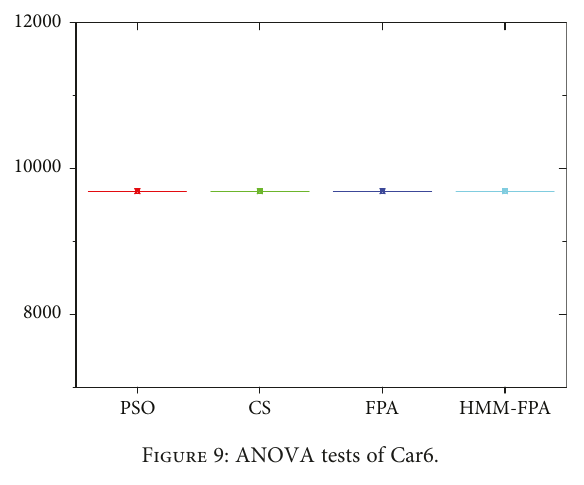
Figure 9: ANOVA tests of Car6.